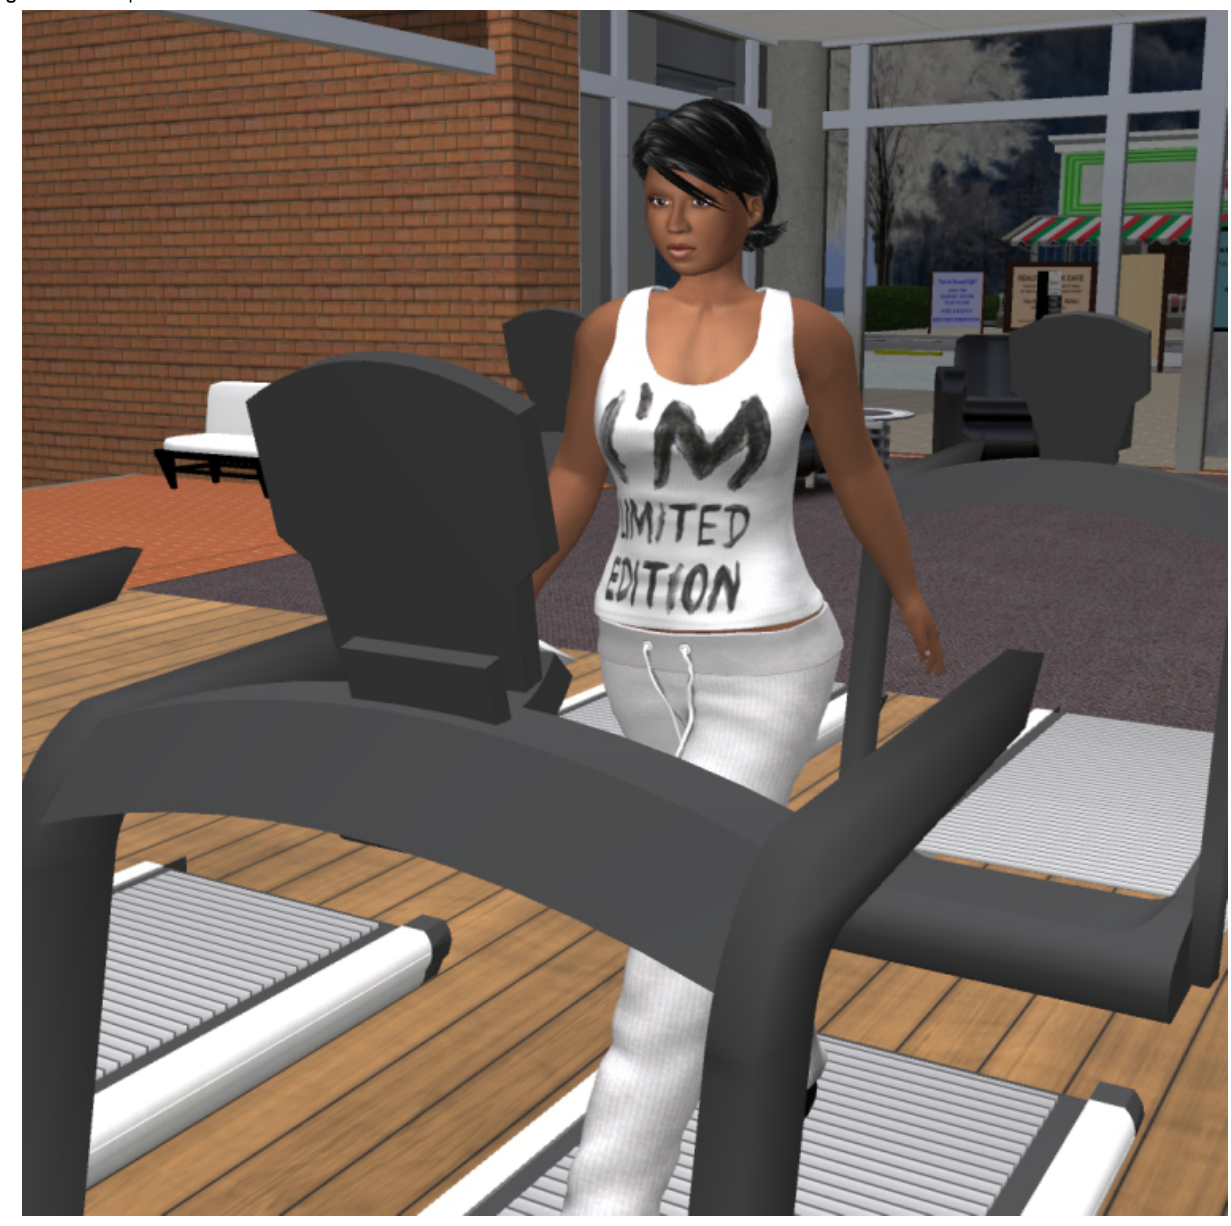
Figure 4. Example of virtual fitness